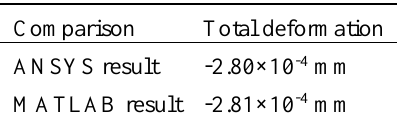
Comparison of results for the simply supported beam with a central moment